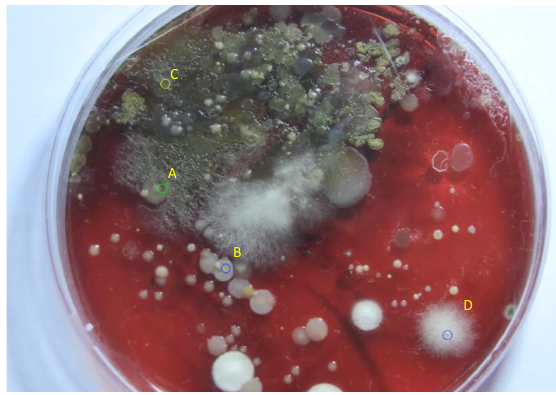
Figure 15. The final frame of petri dish 2, with four locations marked on different colonies, from which population curves are extracted and modeled.